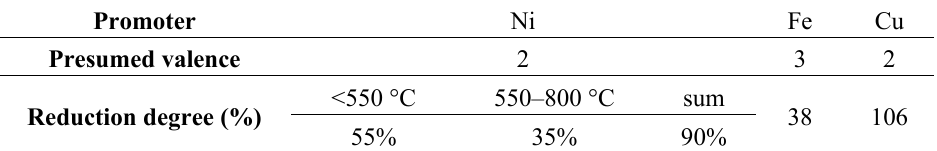
Table 2. Reduction degrees of promoted catalyst calculated from TPR